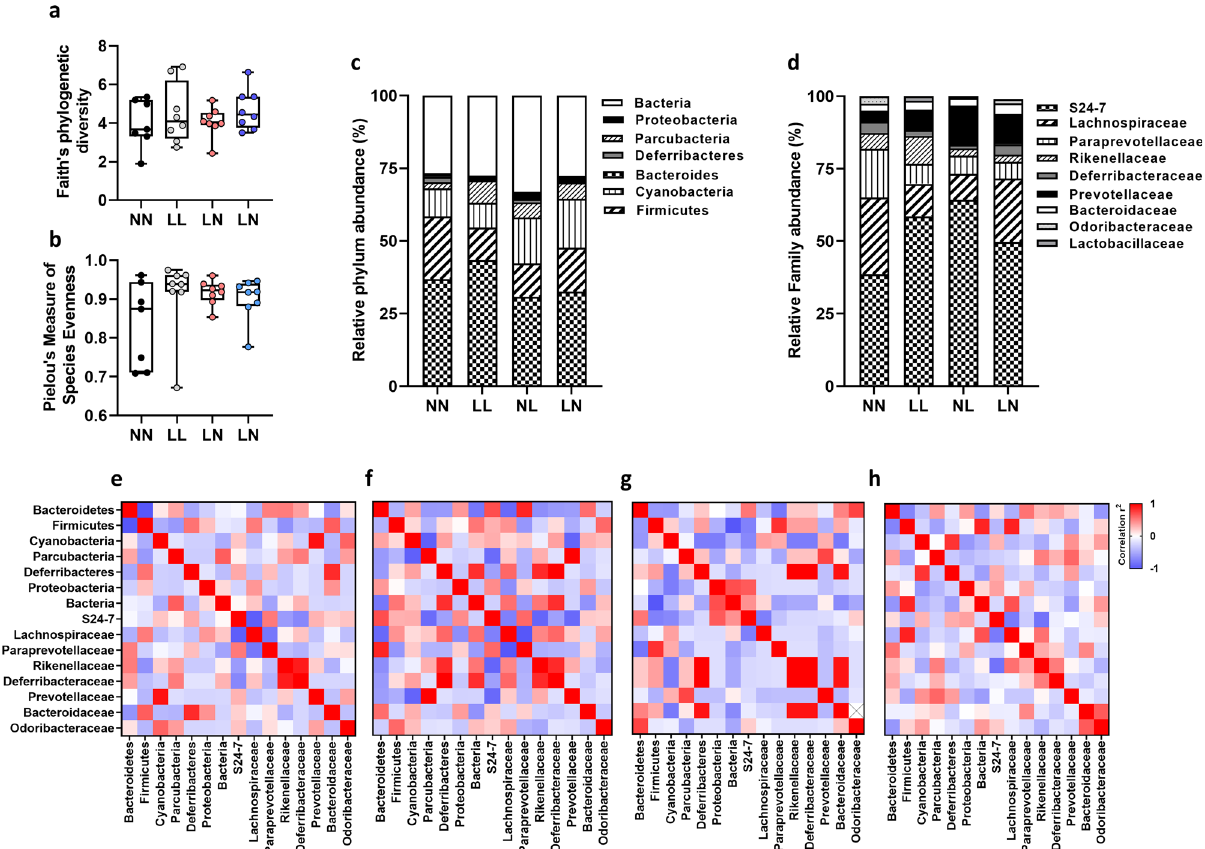
Fig. 4 Analysis of adult-offspring gut microbiome. Assessment of fecal bacterial pro fi les in using a Faith ’ s phylogenetic diversity and b Pielou ’ s measure of species evenness in NN (NPD sperm and NPD seminal plasma), LL (LPD sperm and LPD seminal plasma), NL (NPD sperm and LPD seminal plasma) and LN (LPD sperm and NPD seminal plasma) adult (16 weeks of age) offspring. Relative bacterial c phylum and d family proportions. Correlations between bacterial populations in e NN, f LL, g NL and h LN offspring. N = 4 males and 4 females, each from separate litters. Statistical differences were analysed by one-way ANOVA with Bonferoni post hoc correction a – d and Spearman ’ s correlation e – h